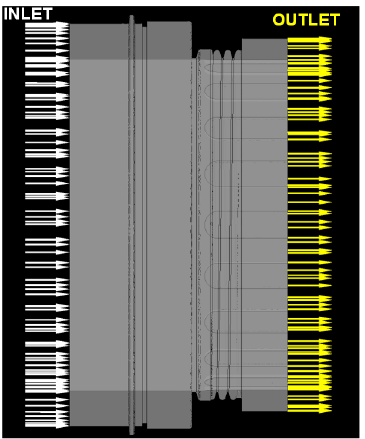
Figure 3. The windback seal assembly with Inlet and Outlet side.